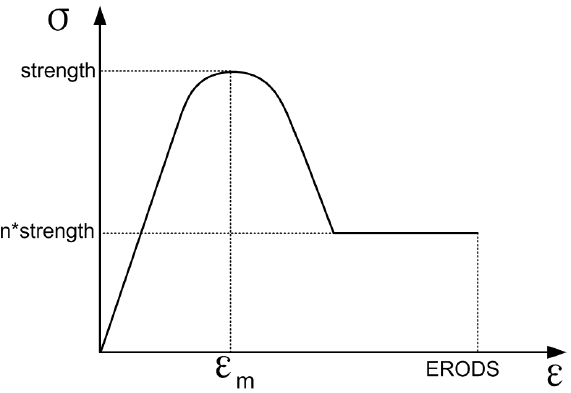
Figure 4. Shear stress vs. shear angle curve.